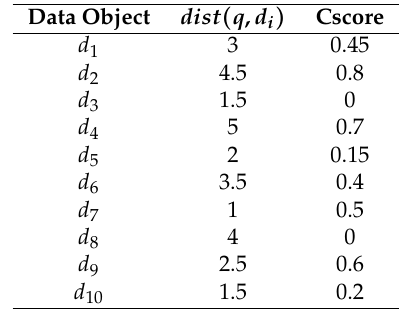
Table 3. Data object details.